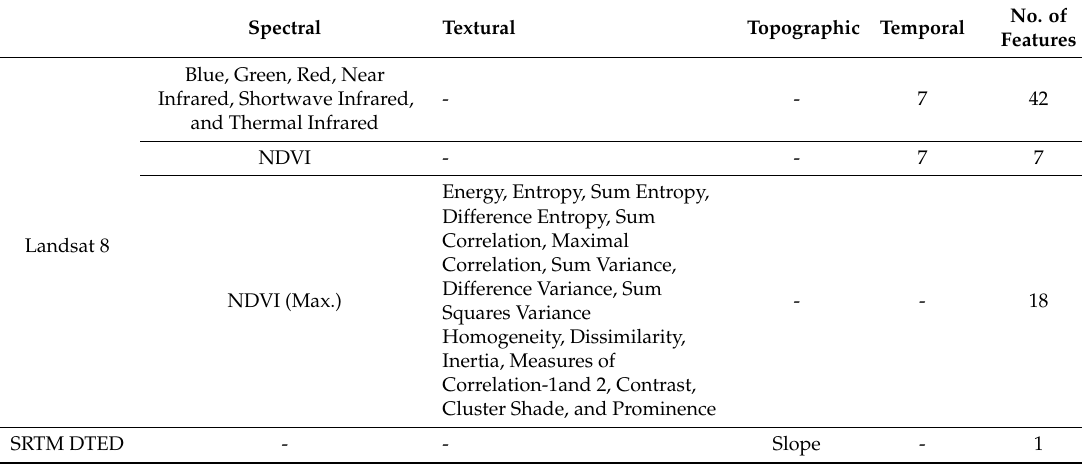
No. of Features - - 18